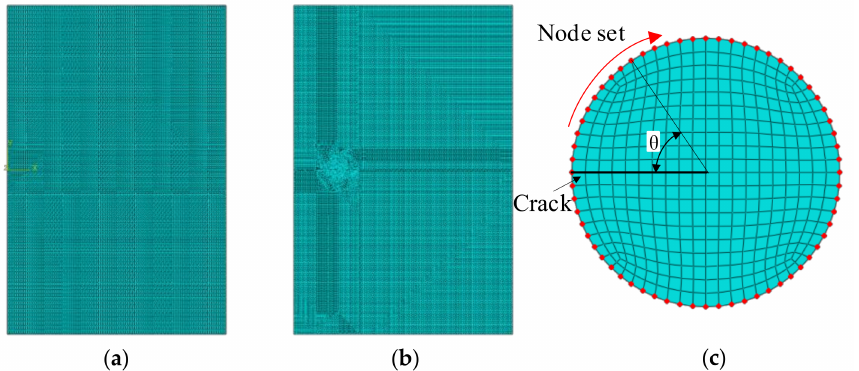
Figure 8. Finite element meshing. ( a ) XFEM model mesh generation, ( b ) Static crack model mesh generation, and ( c ) local mesh generation and node set at crack tip.